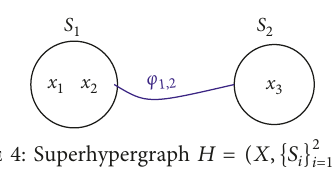
Figure 4: Superhypergraph H � ( X, S